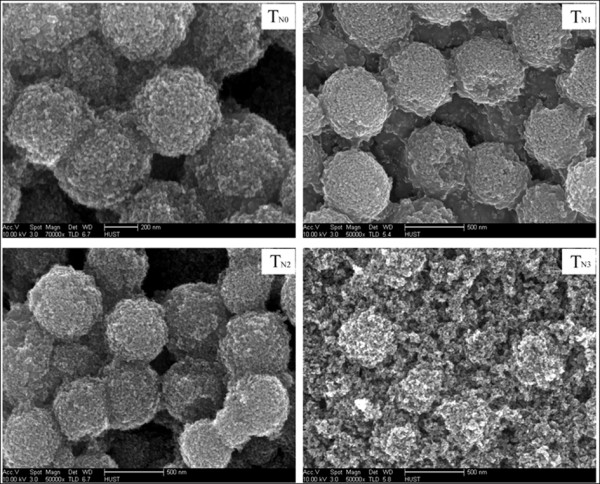
SEM images of nitrogen-undoped and doped TiO2 spheres based films.